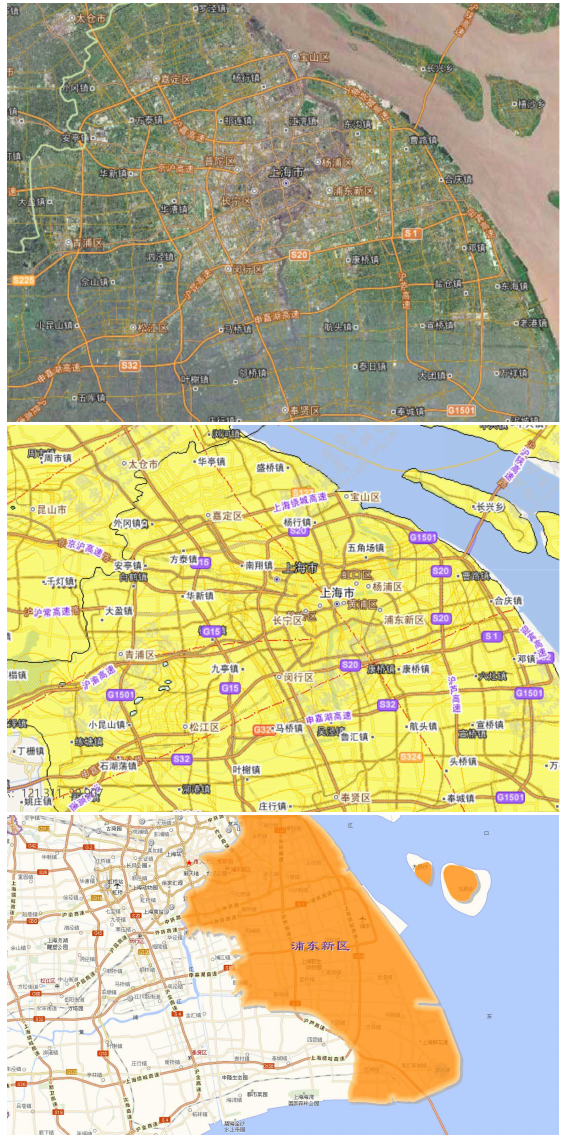
Figure 5. A combinative map of Shanghai with multiple layers. The first one is sensing image. The second one is a geologic map. The third one is a city planning